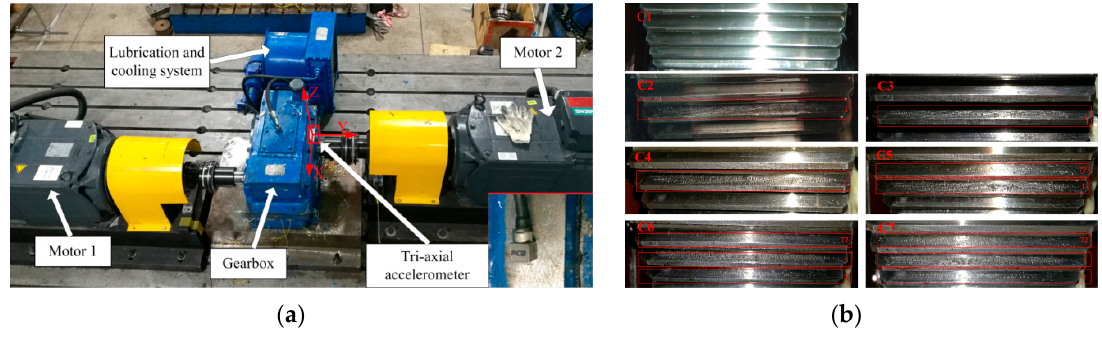
Figure 2. ( a ) Experimental test rig ( b ) gear pitting type.